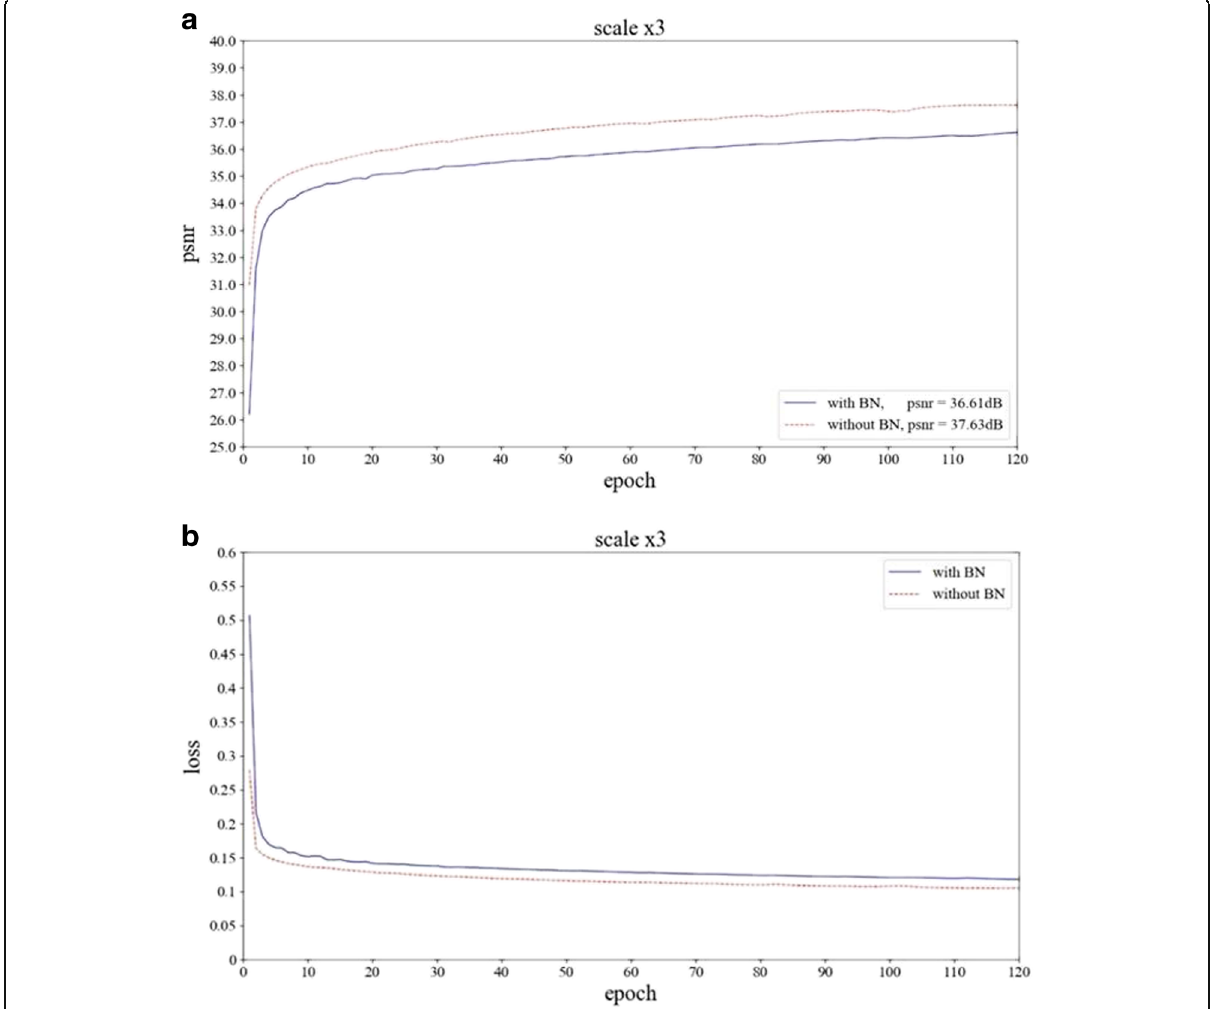
Fig. 6 The experimental results of model with or without BN